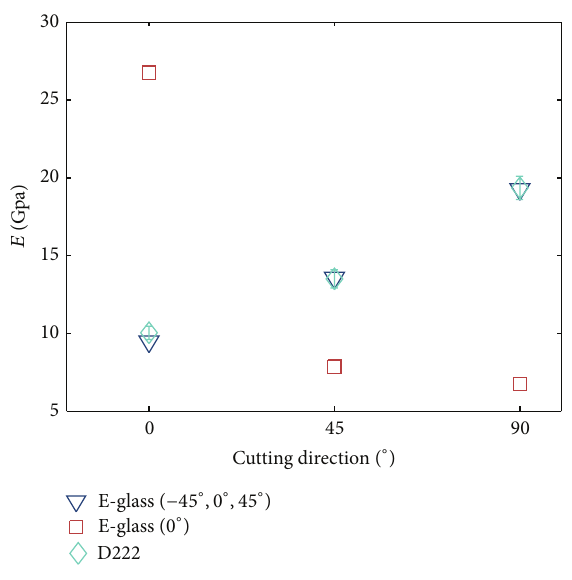
Figure 11: The equivalent elastic moduli of the 6-layer fiberglass composite strips made by the mixed E-glass (− 45 ∘ , 0 ∘ , 45 ∘ ) and the E-glass ( 0 ∘ ) in D222 layer configurations.